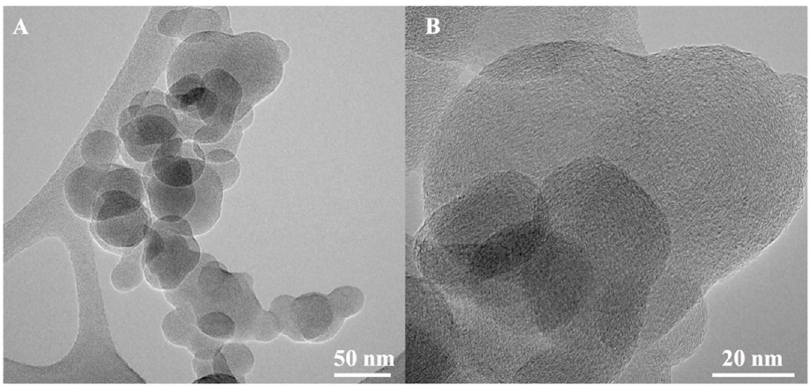
Figure 1. TEM image of a carbon black ( A ) aggregate and ( B ) primary particle.